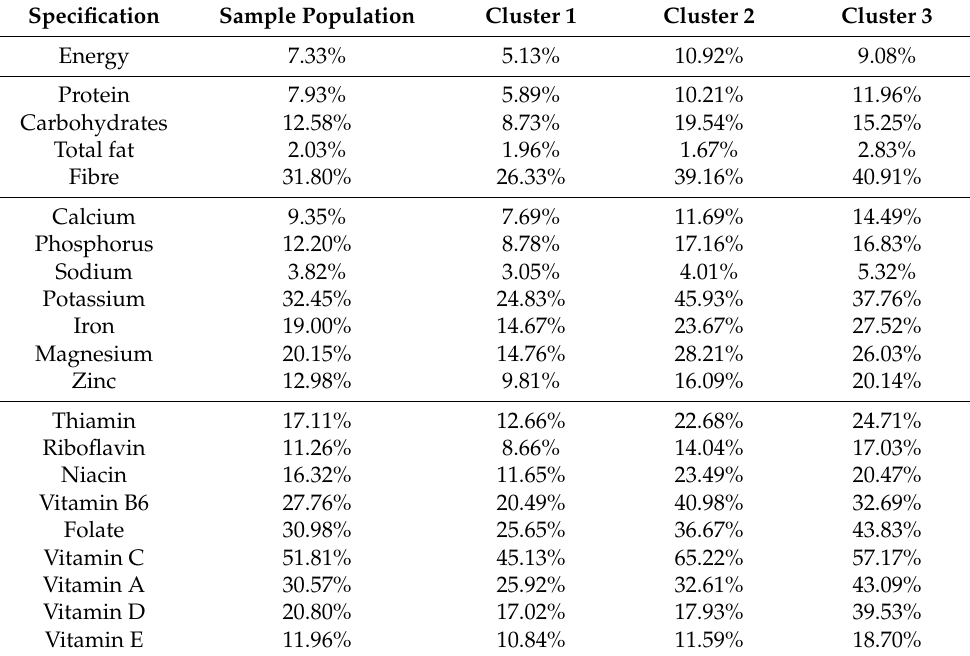
Table 7. Cluster analysis: percentage contribution of energy, macronutrients, minerals, and vitamins from vegetables, potatoes, and their products.